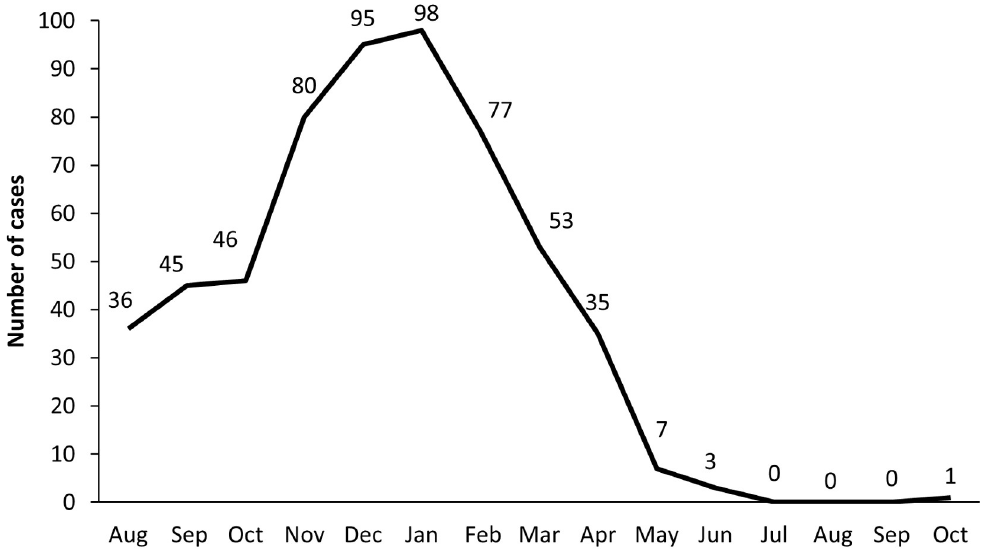
Fig 1. Epidemic curve of measles cases diagnosed at the major tertiary Greek Pediatric hospital, "Aghia Sofia" Children’s Hospital, Athens, 08/2017-10/2018 (n = 578).